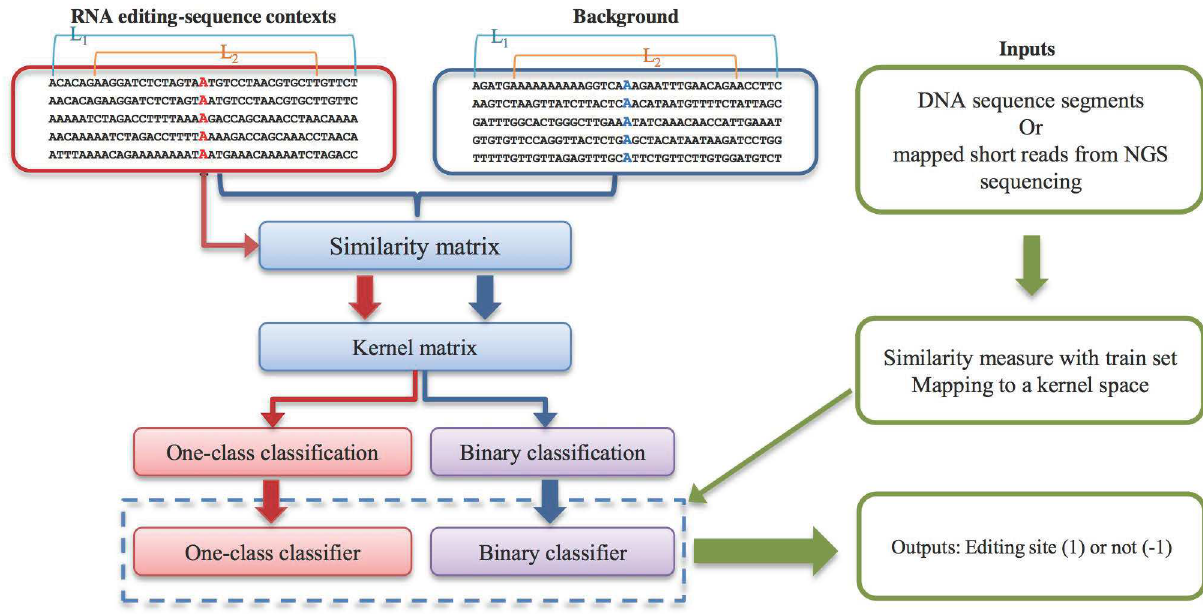
Fig 1. The flowchart of the proposed method. First, we obtain flanking sequencessurroundingthe known editing sites and background sets from the reference genome. Second, we measure the similarity of sequence segments pairs (background sets are not used during the trainingprocess for one-class classification). Then the generated similarity matrix is mapped to string kernel space. For this kernel matrix, the training process tries to find a maximal margin hyperplane, which is usually achievedby quadratic programming. Based on a generated model from the training process, predictioncan be made, using any given sequence or mappedshort reads from next generation sequencing by extracting adeninecentered segments. L 1 : length used for calculating edit distance. L 2 : length used for calculating Hamming